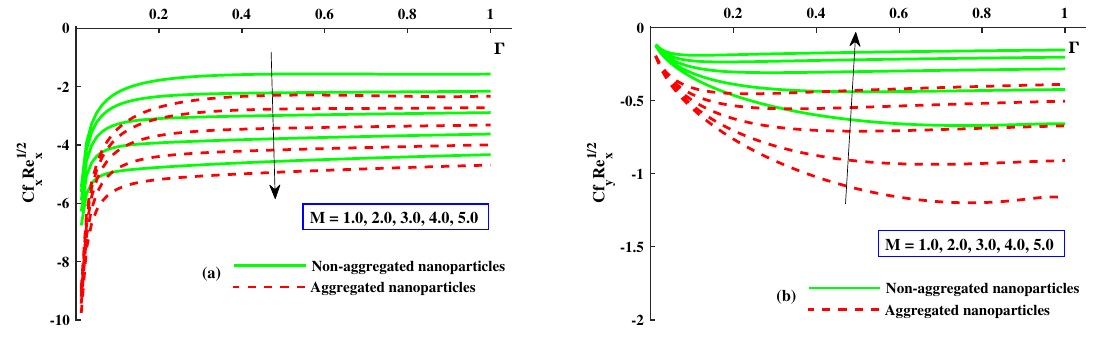
1 / 2 x in x-direction, and Cf y Re